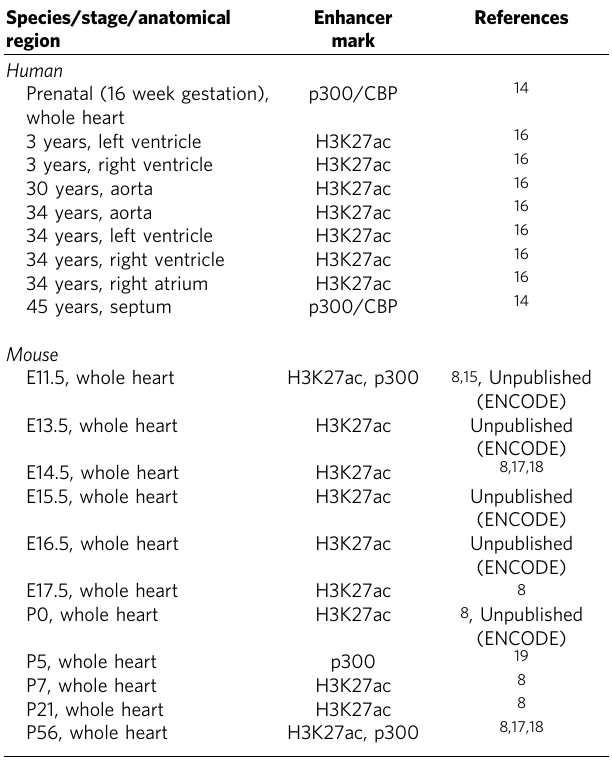
Table 1 | Data sets included in the integrative epigenomic analysis.